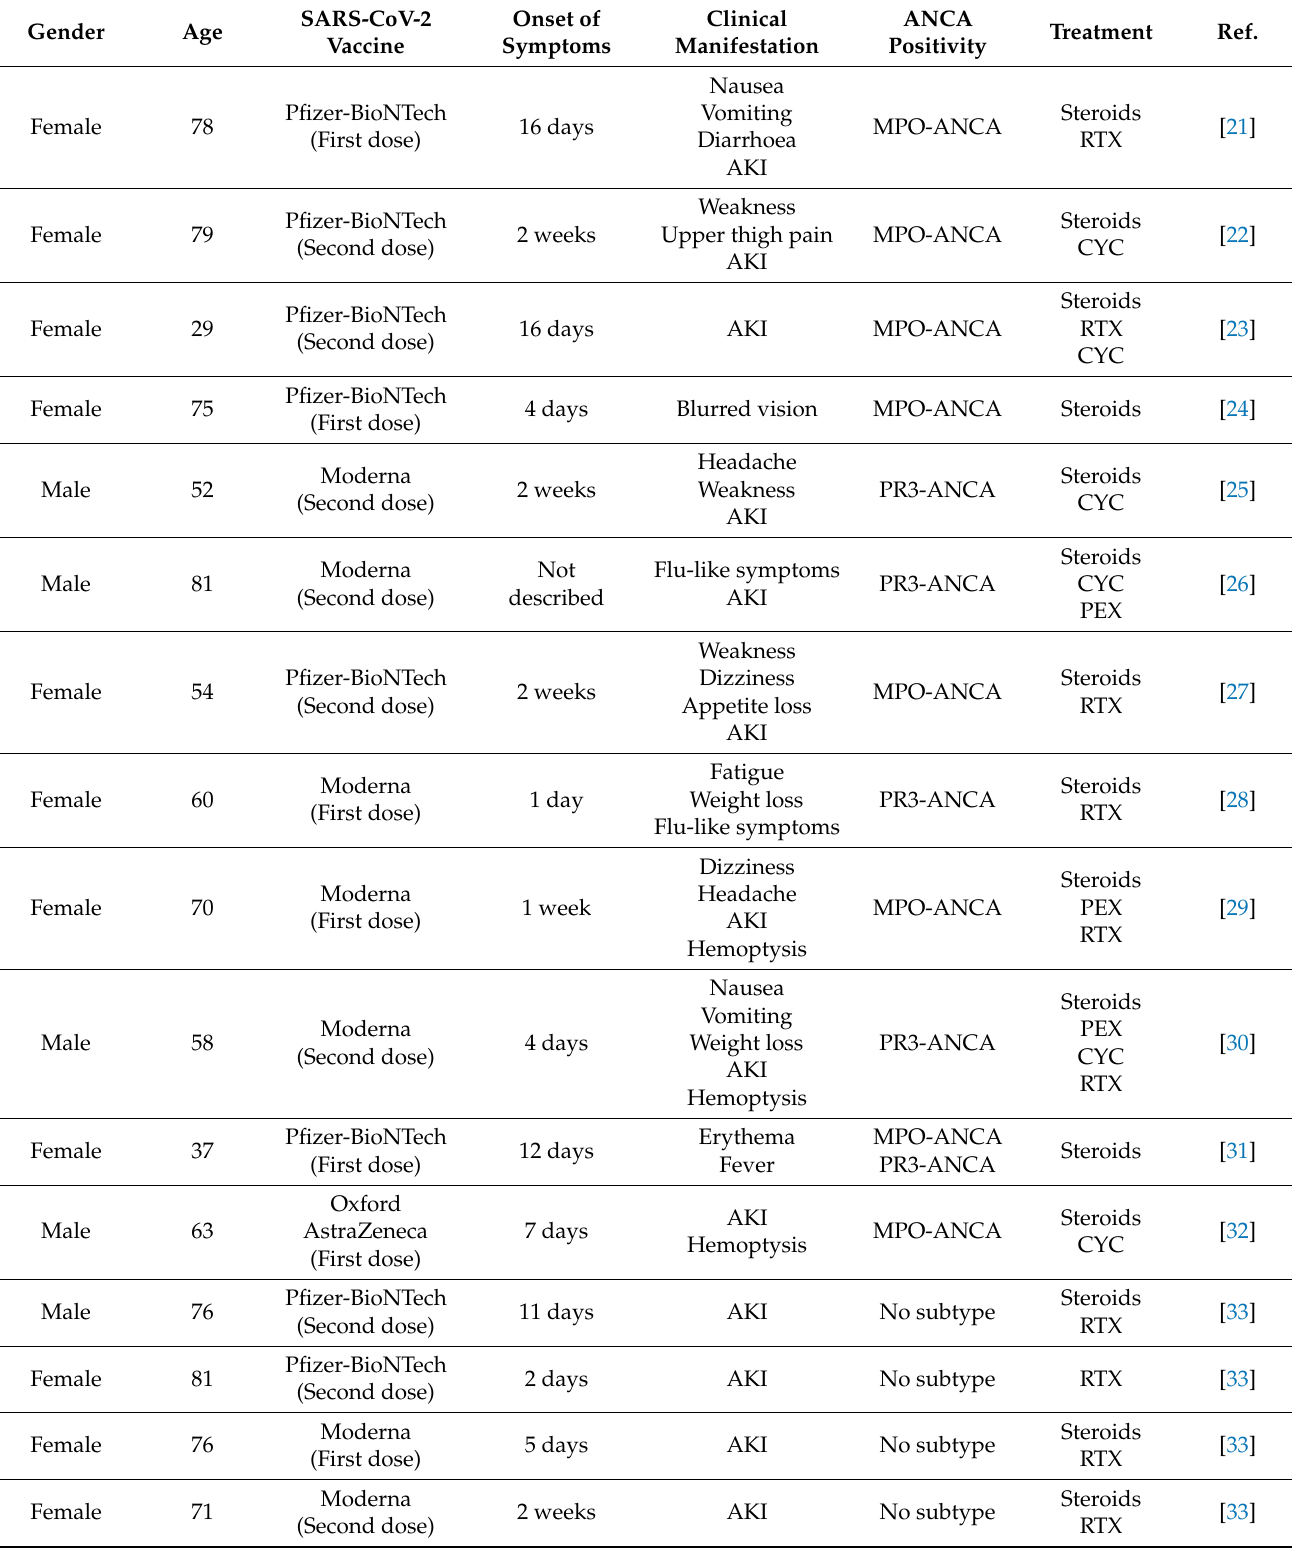
Table 2. Reported cases of de novo AAV after SARS-CoV-2